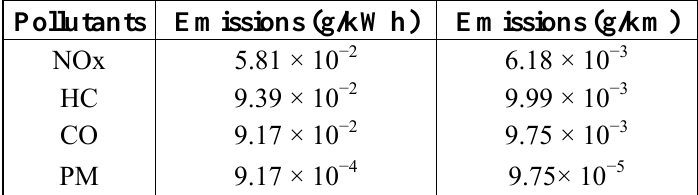
Table 18. Emissions from the LETHE™ City Car on urban routes.